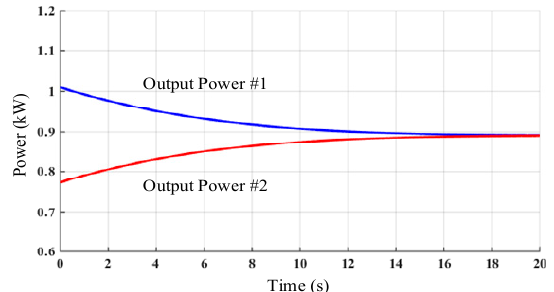
Figure 7. Decreasing SoC in the discharging process.